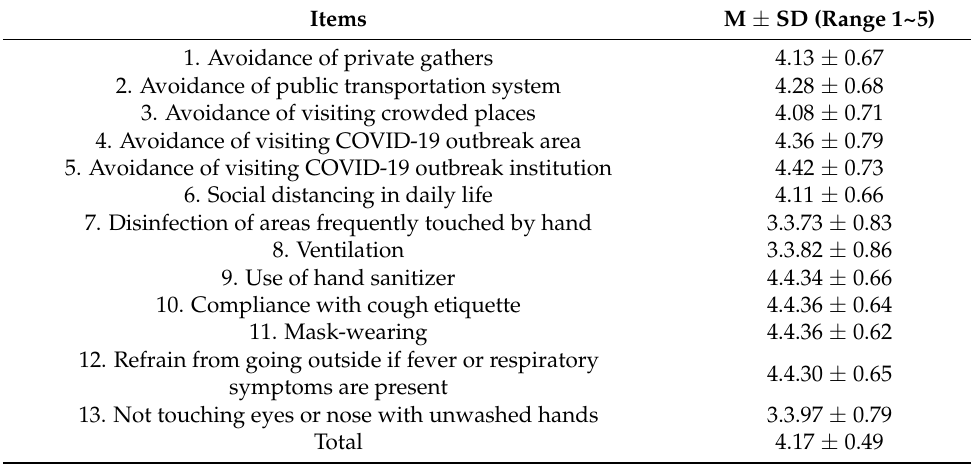
Table 3. Descriptive statistics of infection prevention behavior about COVID-19 (N =